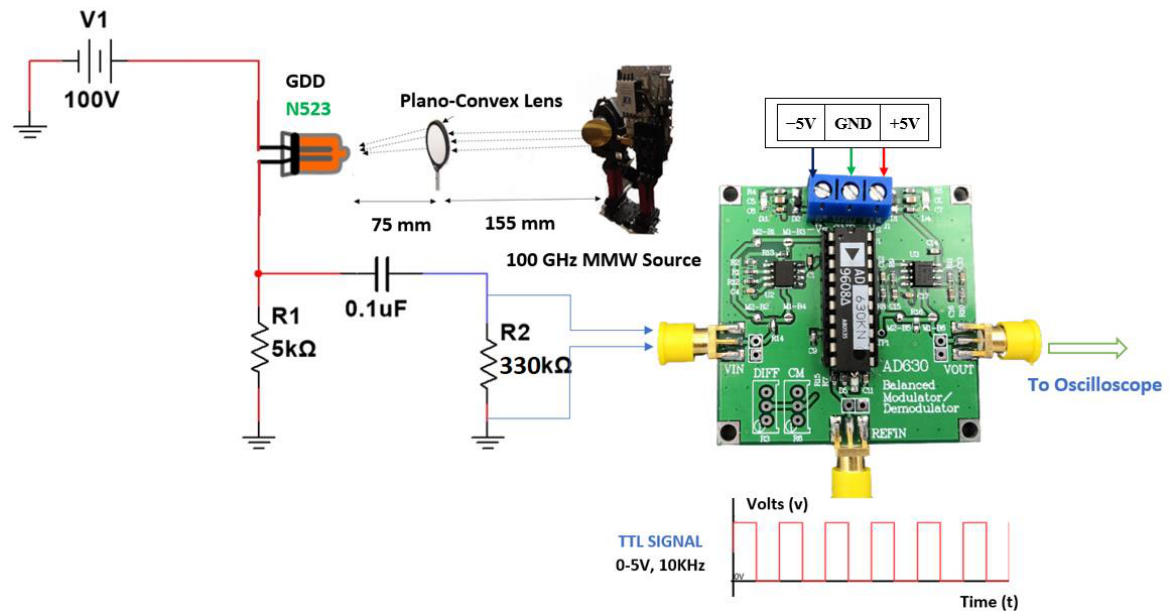
Figure 3. Experimental setup for measuring the minimum detectable signal using a lock-in amplifier integrated to a GDD detection